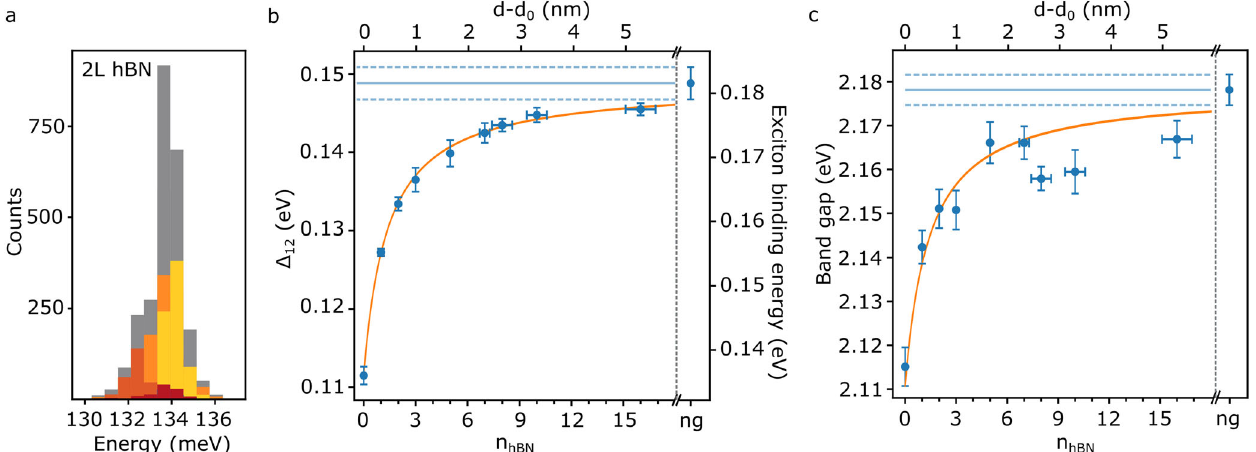
Fig. 2 Dielectric screening as a function of WS 2 – graphene distance. a Exemplary histogram of the exciton 1s-2s energy difference for two layer thick hBN spacers and four individual samples (total: gray bars, individual samples in color). b Distance dependence (upper x -axis) of the energy separation of the excitonic 1s and 2s levels (blue points) realized by n hBN hBN spacer layers (lower x -axis). The approximate exciton binding energy is given on the right axis (see text for details). The data point of no graphene ( “ ng ” ) is equivalent to an in fi nite separation of WS 2 and graphene. The orange line is a fi t to the data with a one-over-distance dependence. c Quasiparticle band gap as a function of hBN spacer layers and interlayer distance. The orange line depicts the fi t results using a one-over-distance dependence. Datapoints and error bars in ( b ) and ( c ) are the means and standard deviations of the distribution of values of all